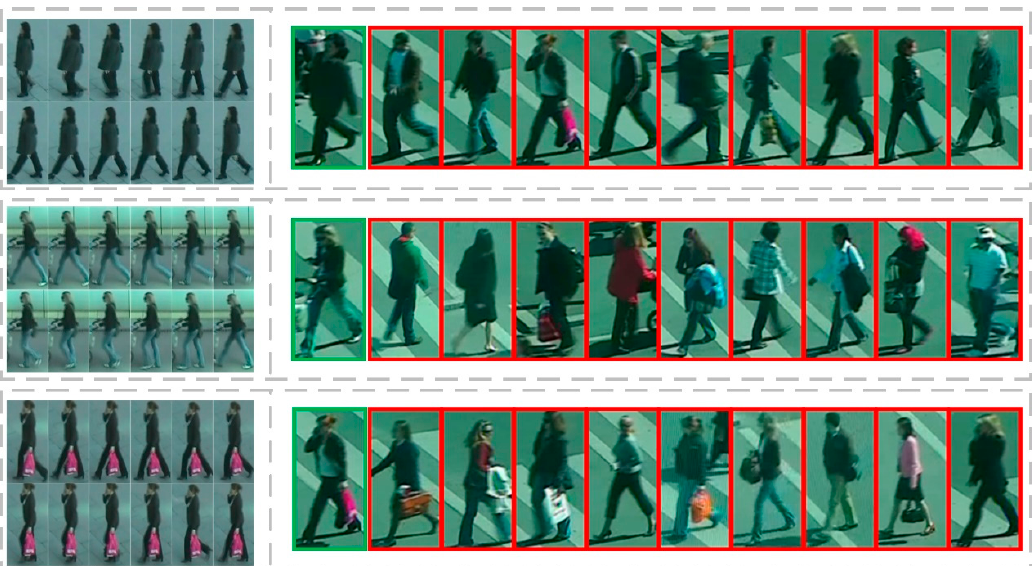
Figure 8. The re-identification results of some people in the proposed architecture in the PRID-2011 dataset. The first column in the figure represents the probe video. The second column is the result of sorting the top ten with the distances, where the green boxes indicate the first and the same person, and the red boxes are the wrong match.